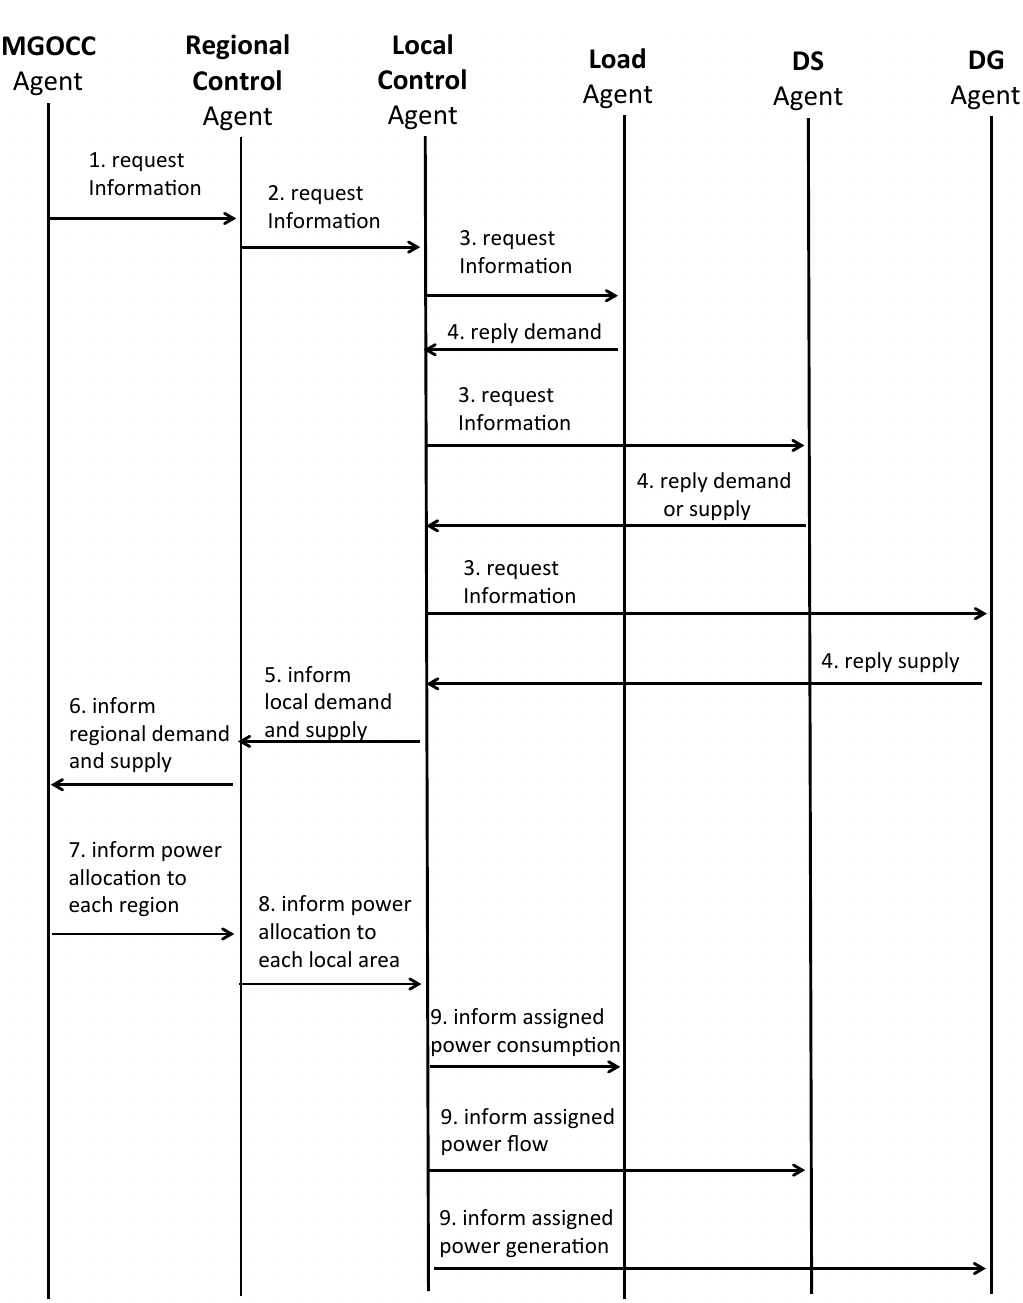
Figure 5. The message flow among agents.